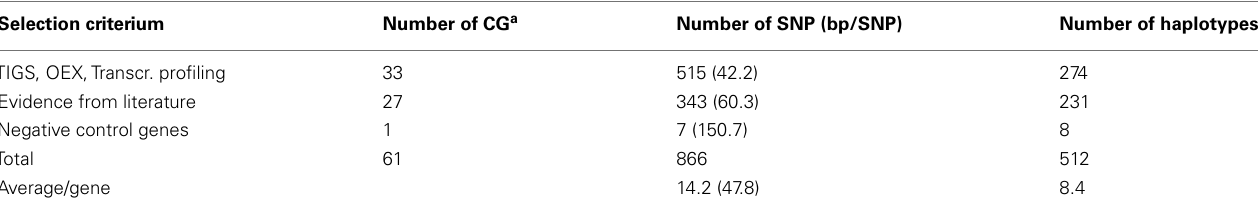
Table 3 | Summary of polymorphic candidate genes used for association of allelic variants with traits by re-sequencing. Selection